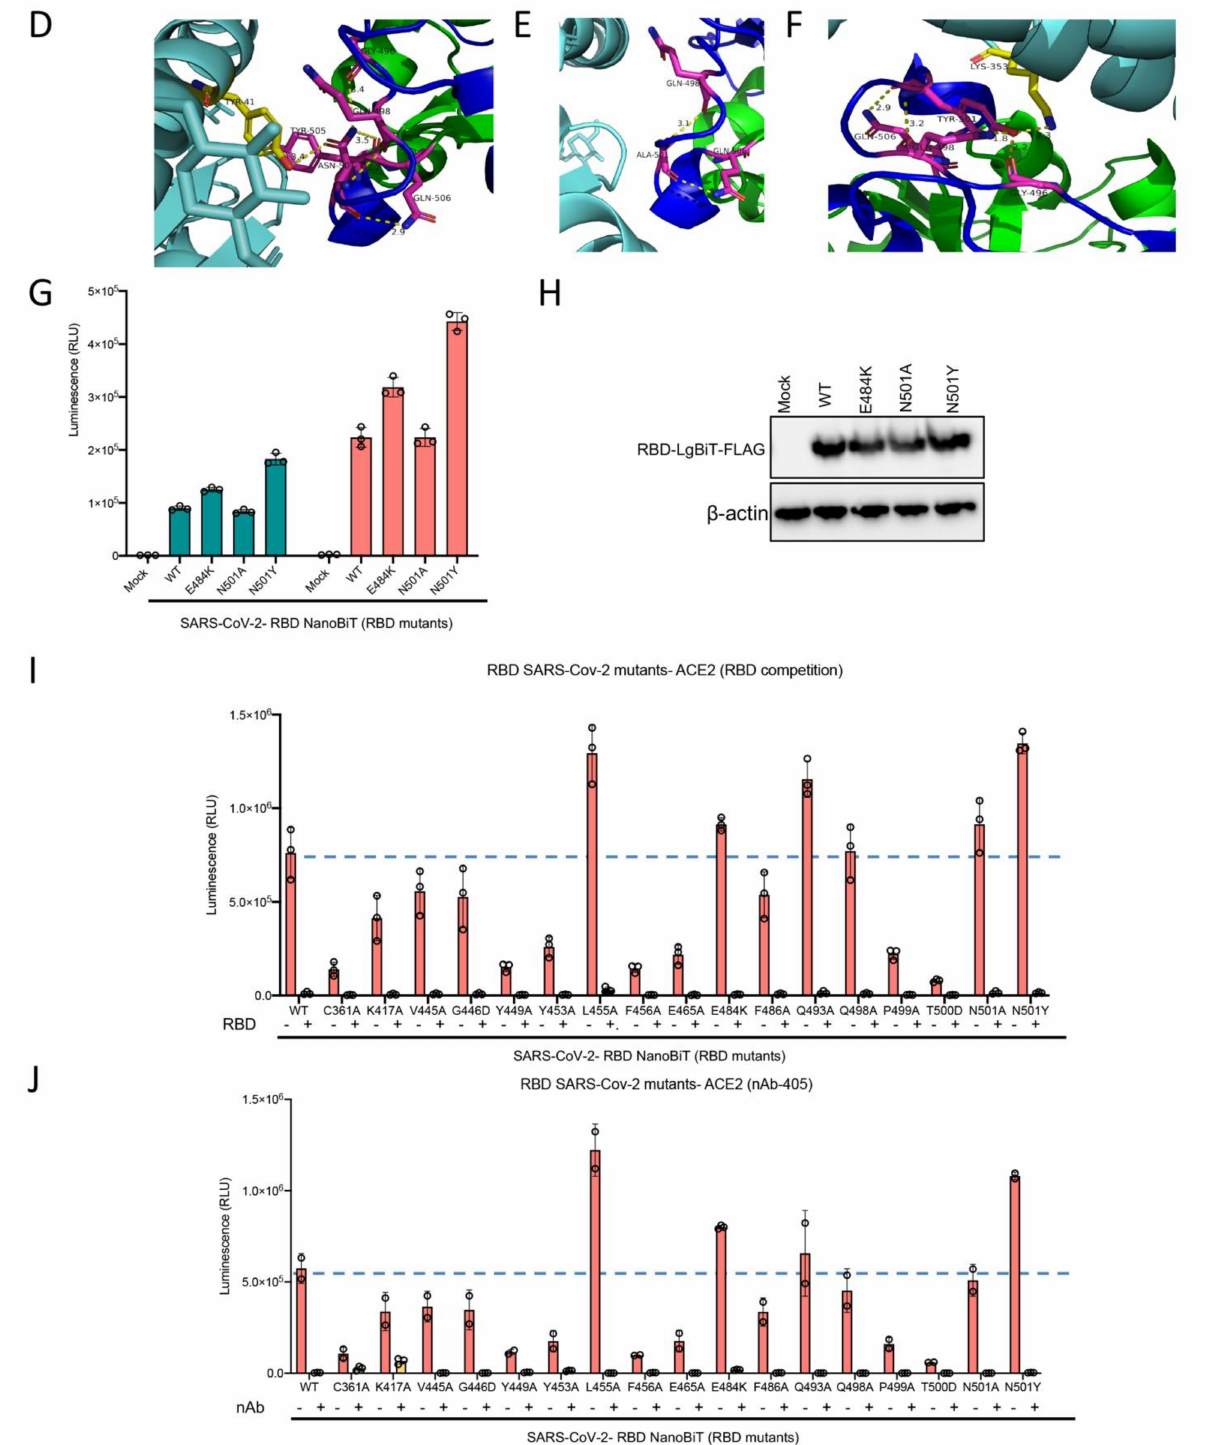
Figure 6. ( A – F ) Visualization of RBD N501 and E484 mutations. ( A ) Overall structure of RBD and ACE2 interaction. ( B ) The loop structure in RBD containing E484 residue. ( C ) Predicted structure following E484 residue mutation to lysine which would not significantly change the nature of its interaction in the loop structure of RBD, ( D ) The N501 residue and its interacting residues in RBM and ACE2. ( E ) Predicted structure when the N501 residue mutates to alanine which would eliminate ACE2 interaction but preserve internal RBM interactions. ( F ) Predicted structure when the N501 residue mutates to tyrosine which would preserve and slightly boost internal interactions, and introduce a stronger interaction site